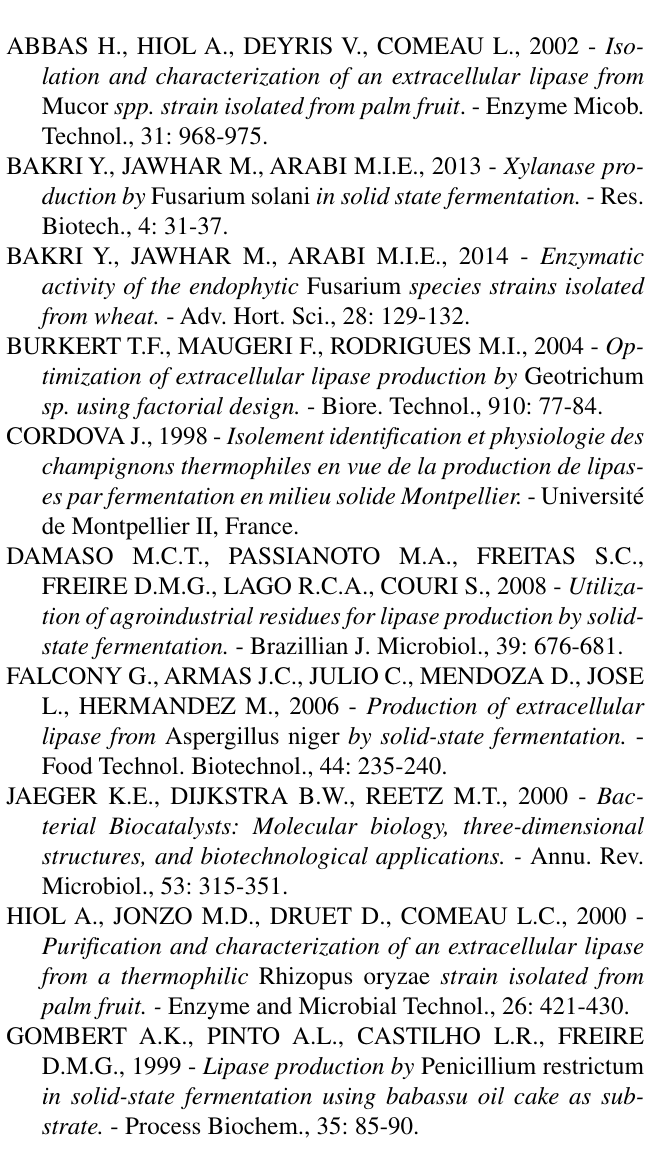
Fig. 3 - Effect of temperature on the activity of F. culmorum SY6